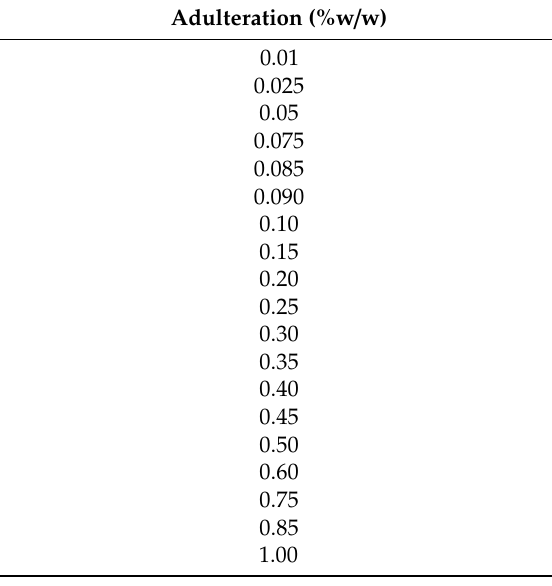
Table 1. Percentage of turmeric powder added to the